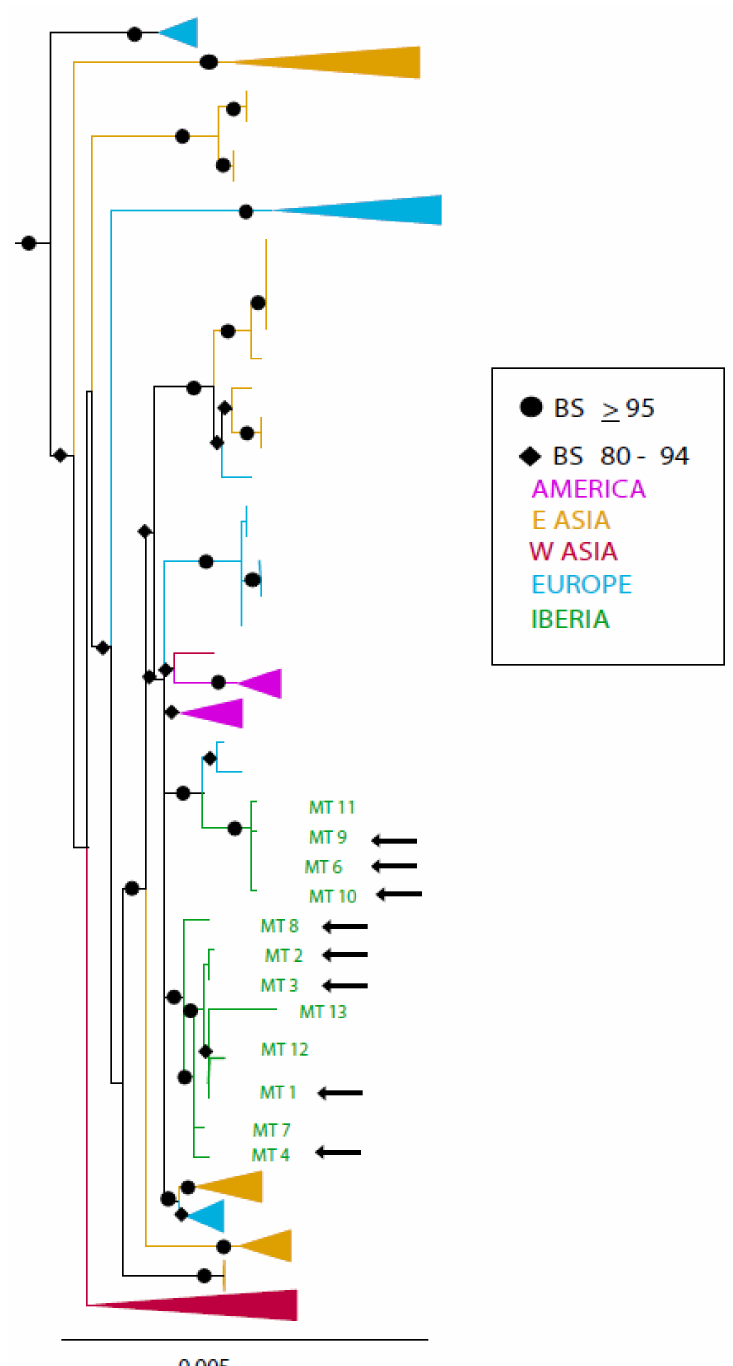
Figure 3. Maximum likelihood phylogeny of near-complete mitochondrial DNA sequences. Iberian haplotypes (green) form two clades, and these clades are most closely related to other European clades (blue). Black arrows indicate mitochondrial haplotypes found in modern Iberian wolves. Collapsed clades group multiple haplotypes from the same geographic region. BS, bootstrap